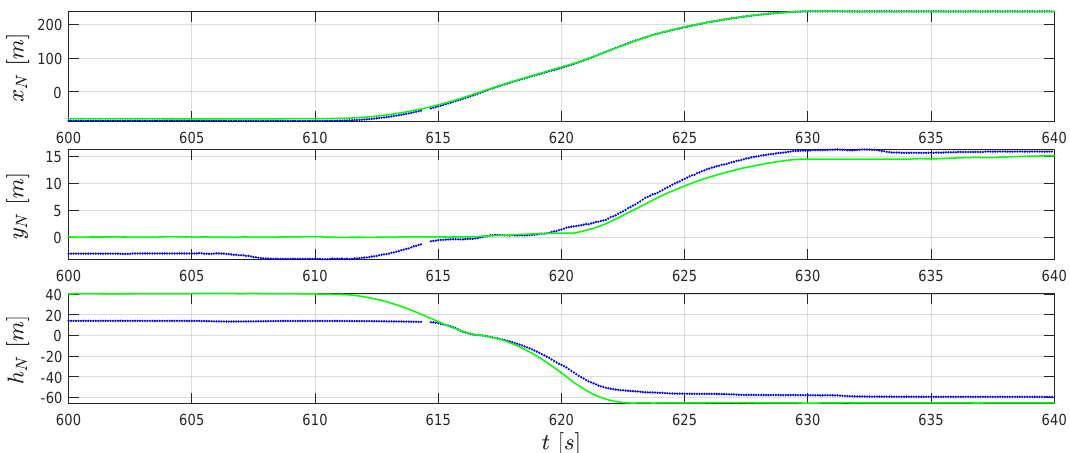
Figure 8. Converted GPS position measurements r N, GPS (blue dots) and the extended RTS smoother reconstructed relative positions r N (green